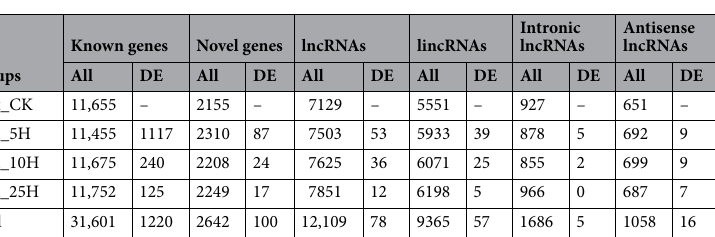
Table 2. The identified known genes, novel genes and lncRNAs in the four banana root groups through lncRNA sequencing. DE: differentially expressed.